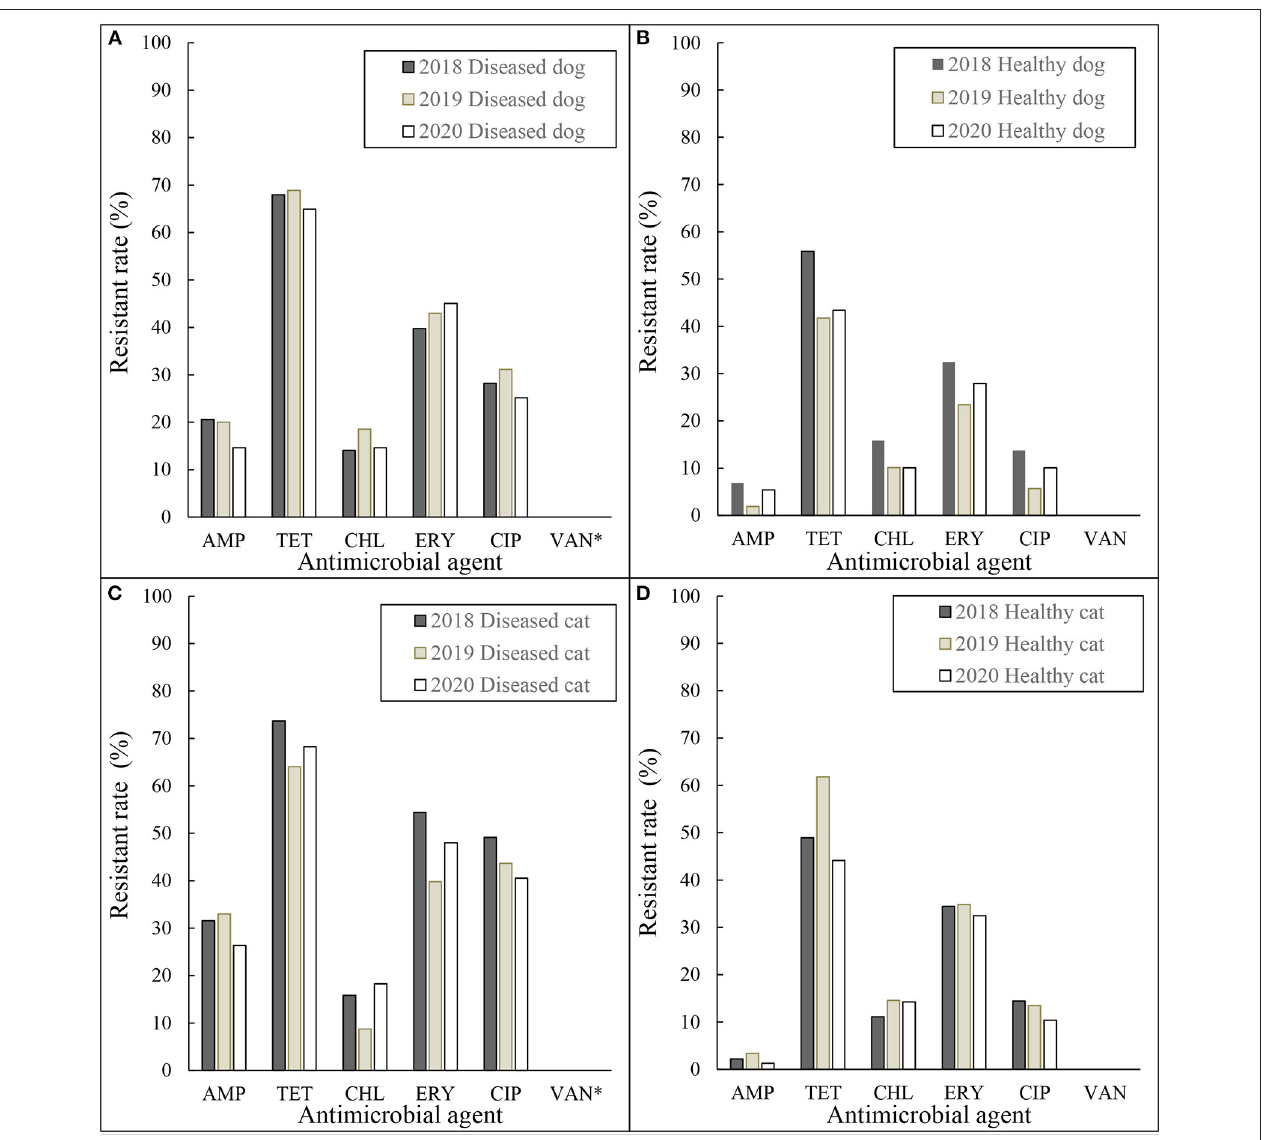
FIGURE 2 | Resistance rates of Enterococcus spp. (A) diseased dog 2018–2020, (B) healthy dog 2018–2020, (C) diseased cat 2018–2020, and (D) healthy cat 2018–2020. AMP, ampicillin; TET, tetracycline; CHL, chloramphenicol; ERY, erythromycin; CIP, ciprofloxacin; VAN, vancomycin. *MIC for Vancomycin was tested for all isolates except diseased dogs and cats in